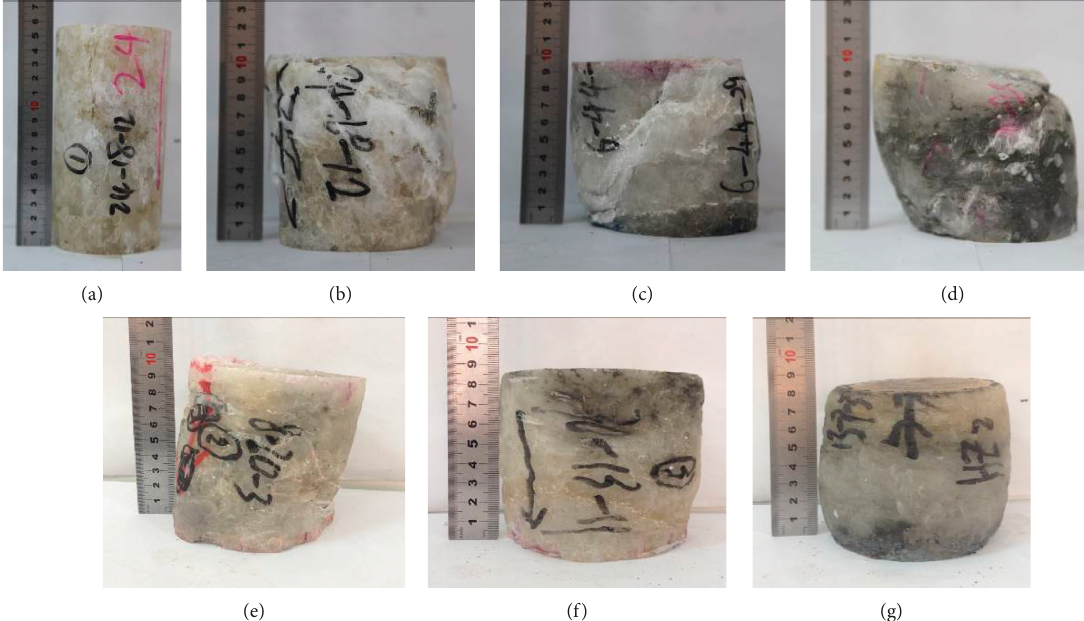
Figure 10: Failure patterns of rock salt under different confining pressures. (a) σ (e) σ 3 � 20MPa. (f) σ 3 � 30MPa. (g) σ 3 �